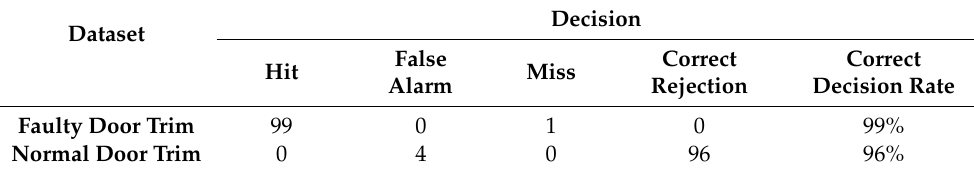
Table 3. The experimental results of the 200 inspections (proposed